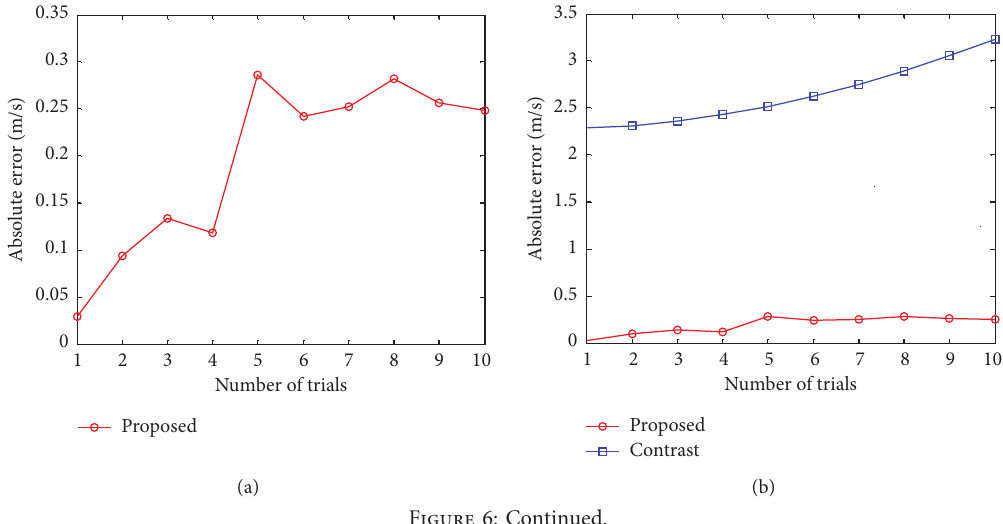
Figure 5: Estimation results as a function of azimuth velocity varying from 1m/s to 14m/s at v error in the azimuth velocity estimation using the proposed method, (b) a comparison of the errors from the proposed method and contrast method, (c) absolute error in the range velocity estimation using the proposed method, and (d) absolute error in the range acceleration estimation using the